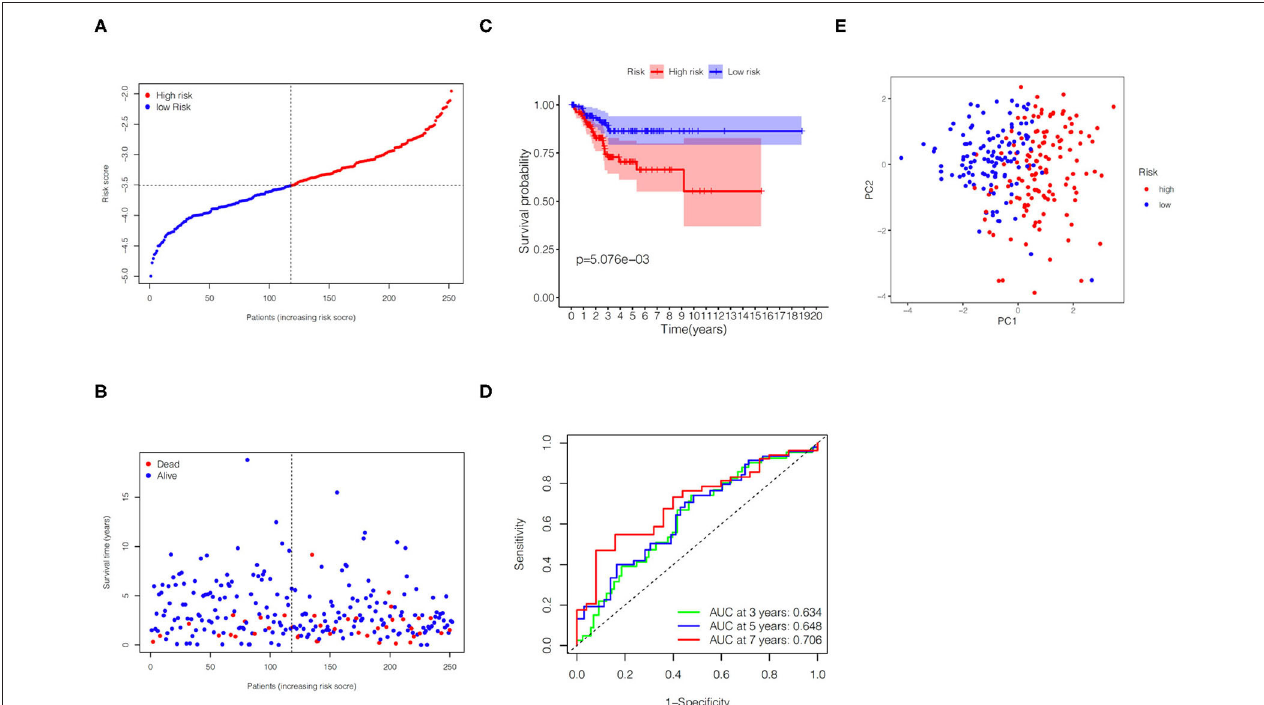
FIGURE 4 | Predictive performance of the gene signature in the TCGA validation set. (A) KM curve for EC patients in the high- and low-risk groups. (B) Verification for predictive value of the gene signature via ROC curve. (C) Distribution of risk scores for EC patients. (D) Distribution of survival time with different risk scores. (E) PCA analysis for EC